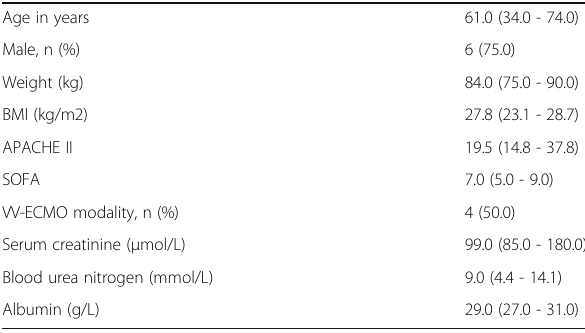
Table 1.1 (abstract 0398). Patient demographic and clinical characteristics presented as median (IQR) or number (percentage)